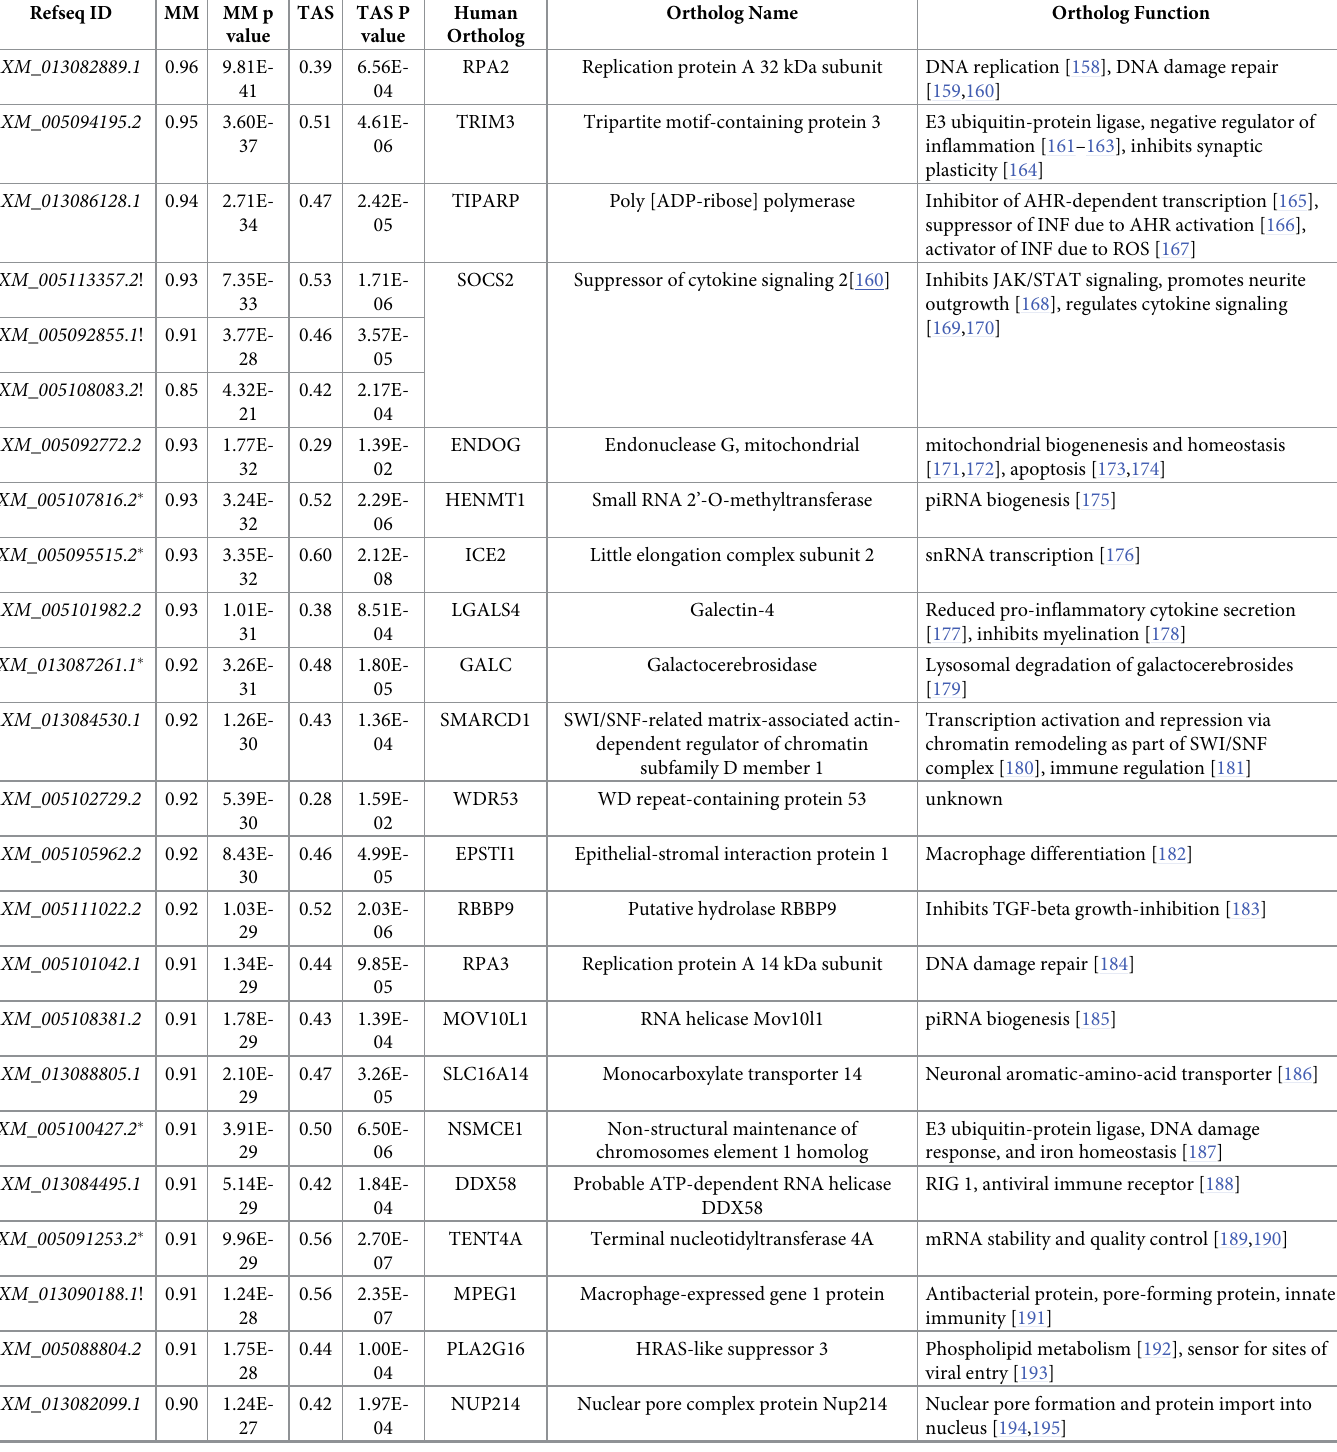
Table 5. Selection of transcripts with highest correlation to transcript co-expression module eigengene (module membership, MM) in the darkgreen consensus module identified in Aplysia californica sensory neurons by WGCNA